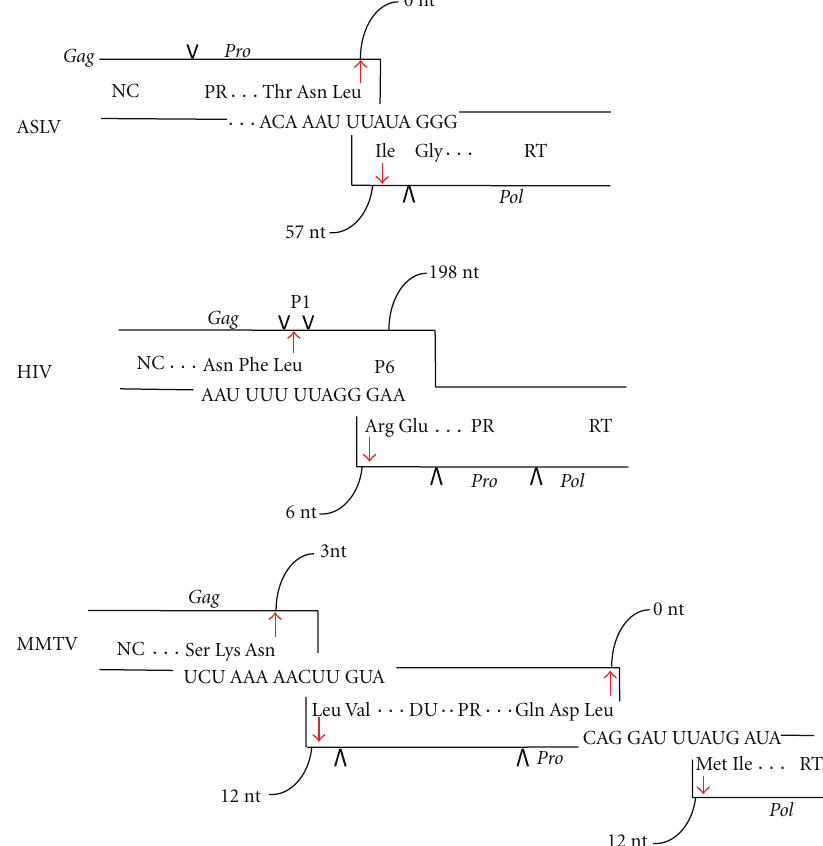
Figure 7: Frameshift suppression in the synthesis of Gag-Pro-Pol. Shown are the nucleotide sequences at the frameshift site and the amino acids encoded in the Gag-Pro-Pol precursors of the indicated viruses. The upper amino acid sequence is read from either the gag or pro reading frame, and the lower sequence is read from either the pro or pol reading frame, as shown. The boxes represent the indicated reading frames. The colored arrows indicate the position of the nucleotide (shown in color) that is read in both reading frames, the Vs represent the positions in the sequence that encode PR processing sites, and the numbers represent the number of nucleotides between the frameshift site and the end of the reading frame (irrespective of the nucleotide that is read in both frames). The nucleotides in the boxes include the beginning and ending codons in the reading frames shown (ASLV: avian sarcoma leucosis virus and MMTV:murine mammary tumor